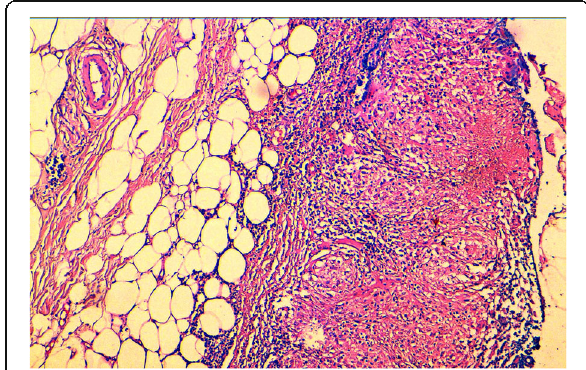
Fig. 1 Histological image of breast tuberculosis showing a necrotizing granulomatous lesion (hematoxylin eosin stain ×100) (patient 5)